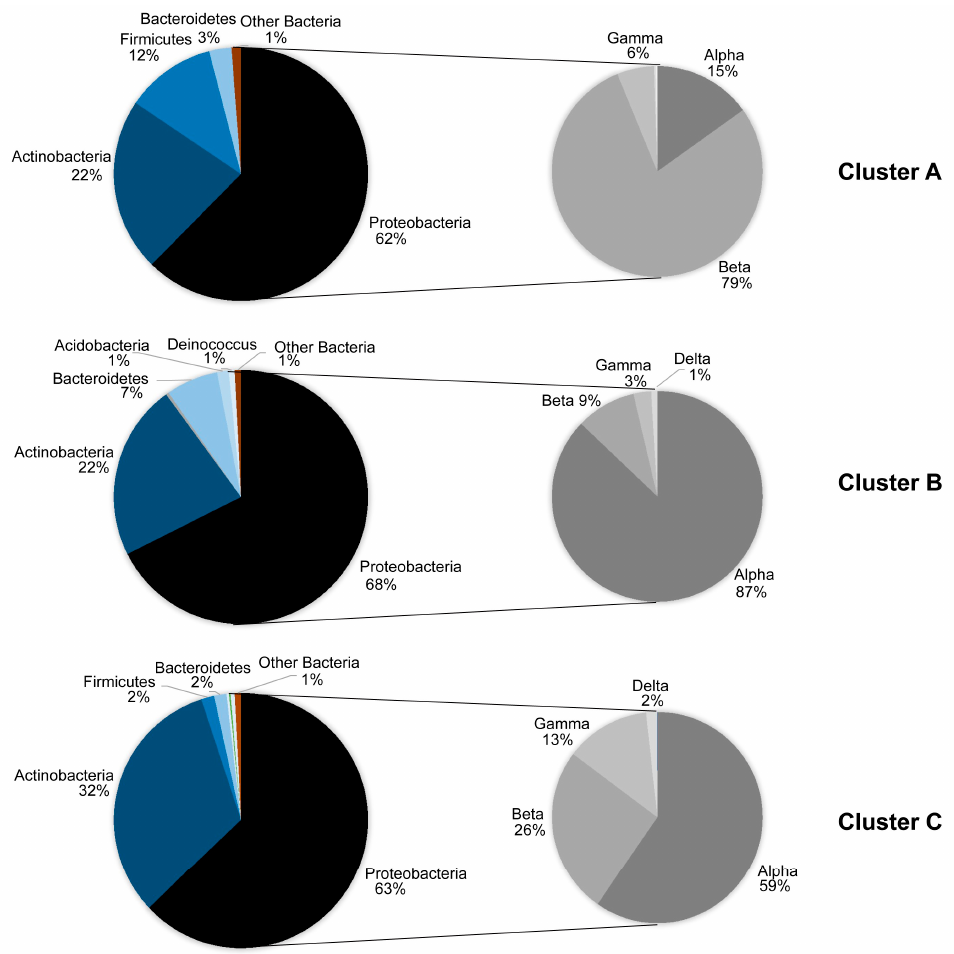
Figure 4. Relative abundances of the major high-level taxonomic groups of bacteria in the three clusters of Figure 3 that are formed using Bray–Curtis dissimilarities and on the basis of SILVA 128 database. To facilitate reading, the groups indicated have > 1% of the total number of reads. Cluster A is made of air samples, whereas clusters B and C are made of phyllosphere samples, primarily winter and summer ones, respectively.